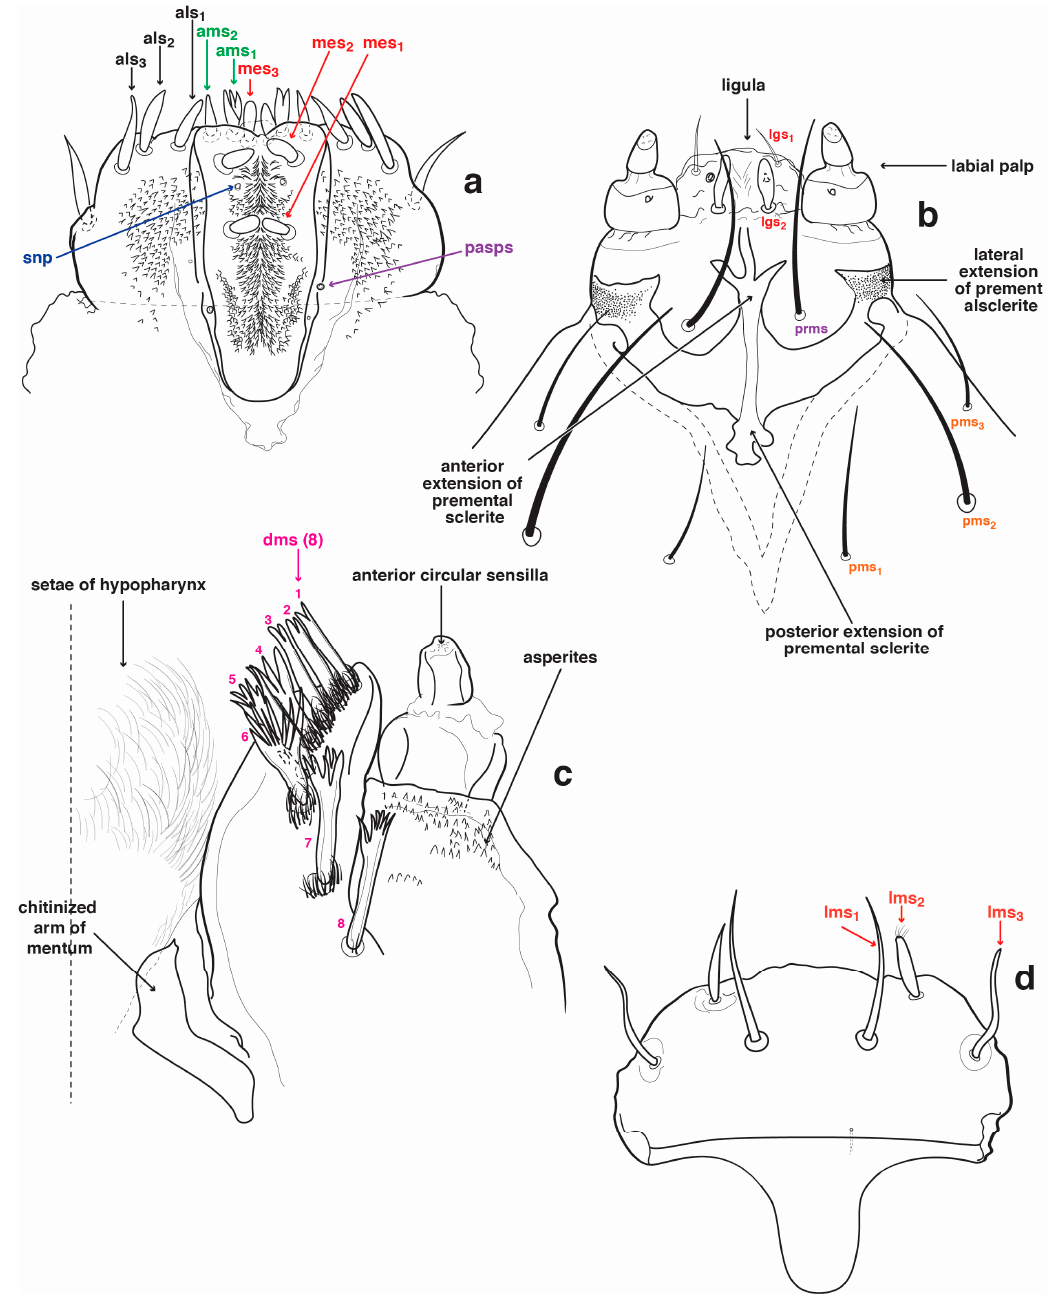
Figure 75. Poteriophorus uhlemanni mouthparts: ( a ) epipharynx; ( b ) labium; ( c ) detail of maxilla and hypopharynx, dorsal view; and ( d ) labrum. Als : anterolateral setael; ams : anteromedian setae; dms : dorsal malar setae; lgs : ligular setae; lms : labral setae; mes : median epipharyngeal setae; pasps : posterior accessory sensory pores; pms : postmental setae; prms : premental setae; snp : sensory pores of epipharynx.